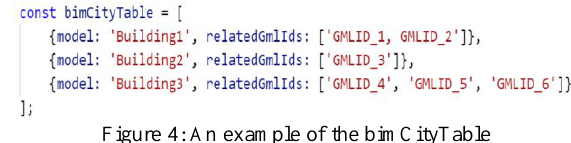
Figure 4: An example of the bimCityTable